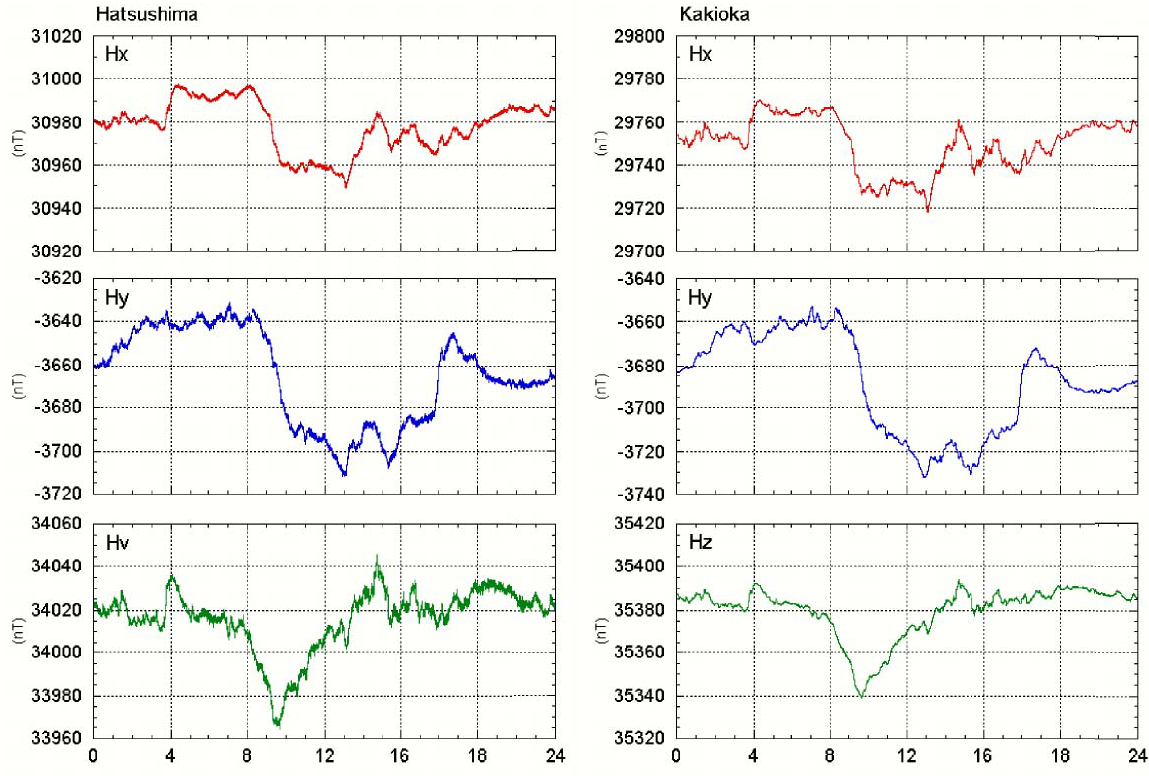
Figure 5. 1-day comparison of the magnetic component’s daily variation, as deduced by Hatsushima Observatory and Kakioka Observatory in Ibaragi prefecture.